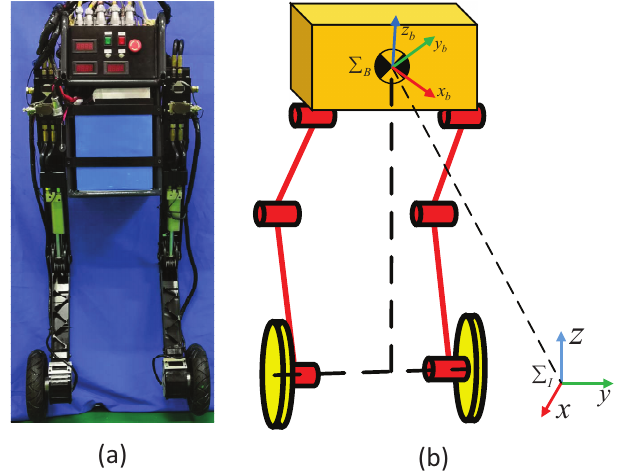
Figure 1. Model of the wheeled biped robot (WBR): ( a ) Scooter robot prototype; ( b ) simplified model of Scooter.